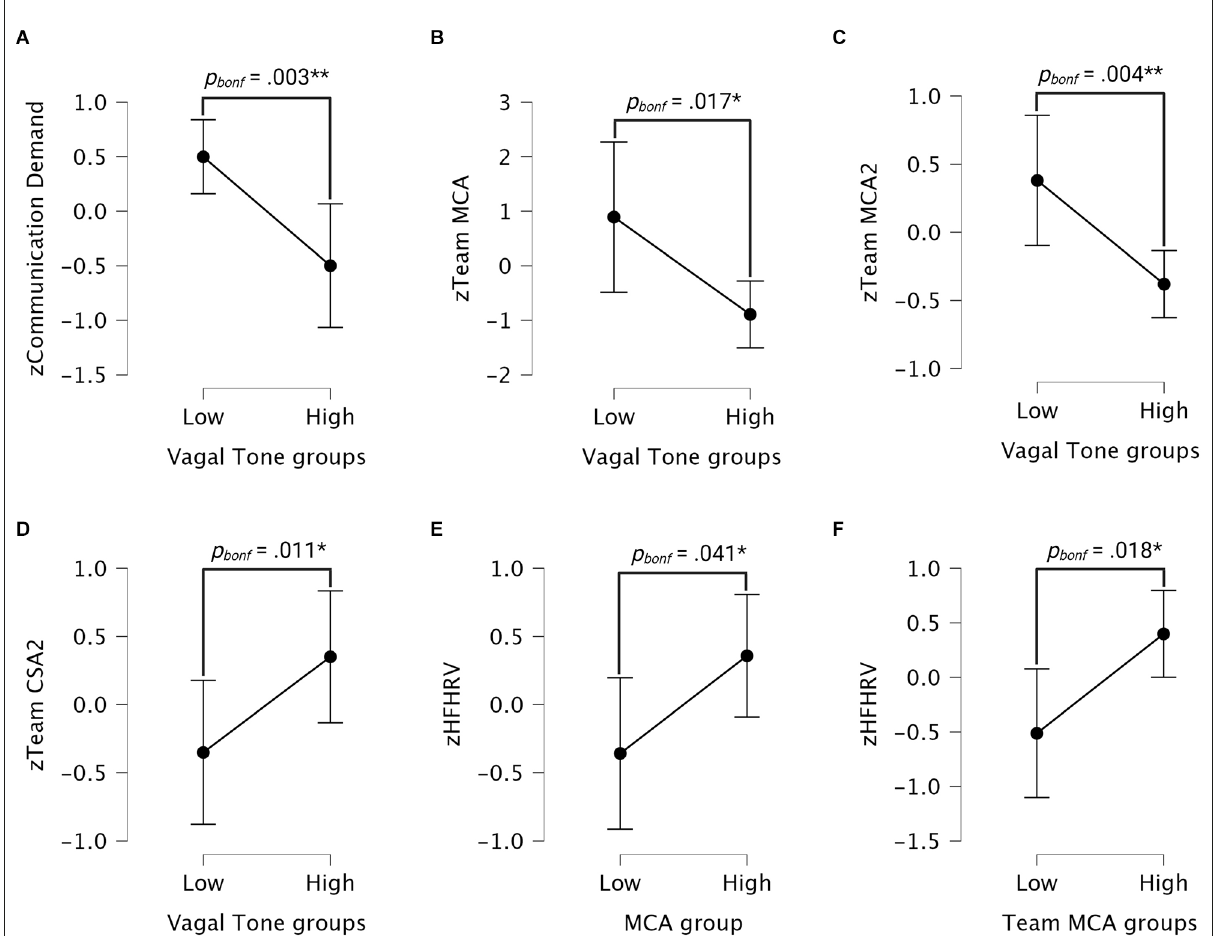
FIGURE6 Interval plots for group comparisons. (A–D) Interval plots for differences in communication demand, team MCA, team MCA2, and team CSA2 scores between individuals with low and high HFHRV. (E) Interval plot showing differences in HFHRV between high and low MCA groups. (F) Interval plot showing differences in HFHRV between high and low team MCA groups. Whiskers are 95% confidence intervals. MCA, Metacognitive accuracy; CSA, Cyber situational awareness; HFHRV, High frequency component heart rate variability; CSA2 and MCA2, CSA and MCA without Kill chain